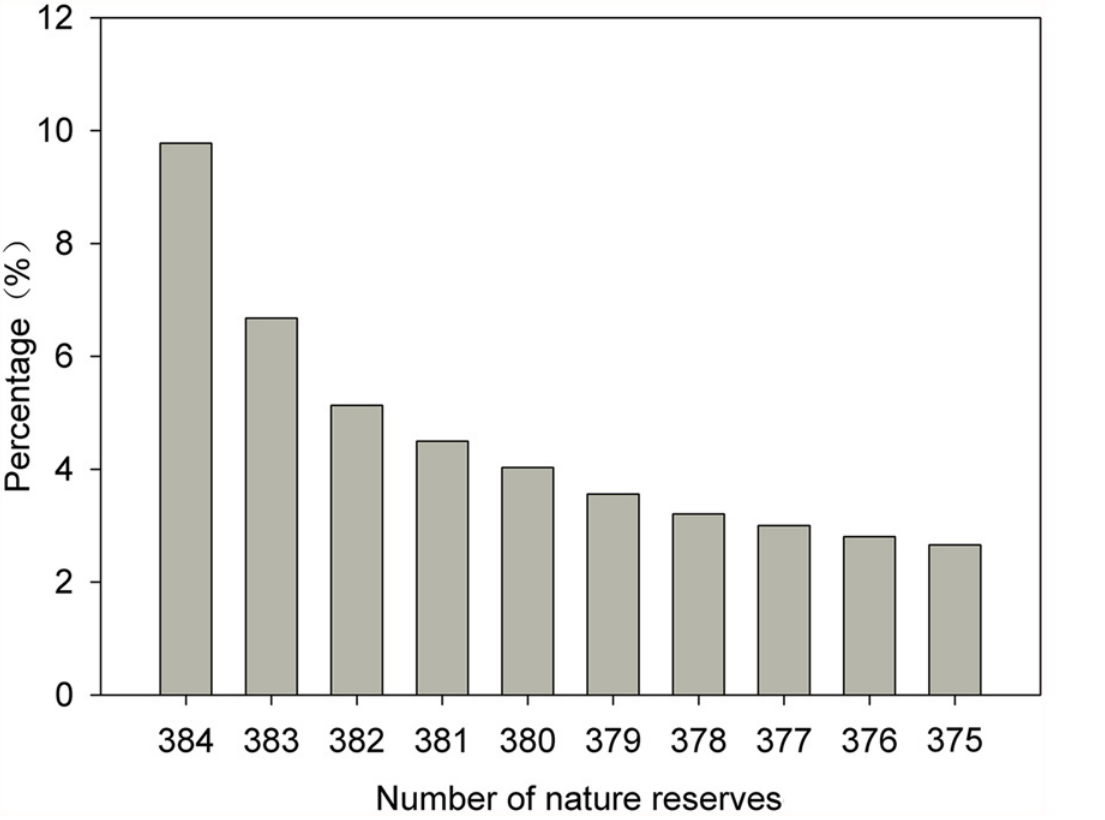
Fig 3. Accumulative percentages of land area protected by NNRs.